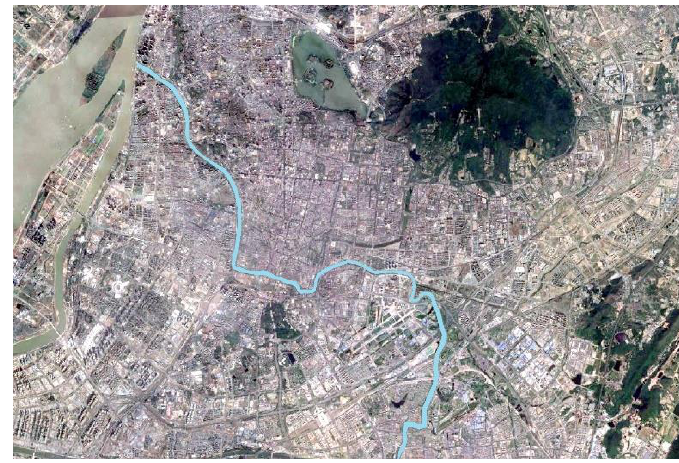
Figure 6. Qinhuai River’s location and representation with bluestrip polygons.